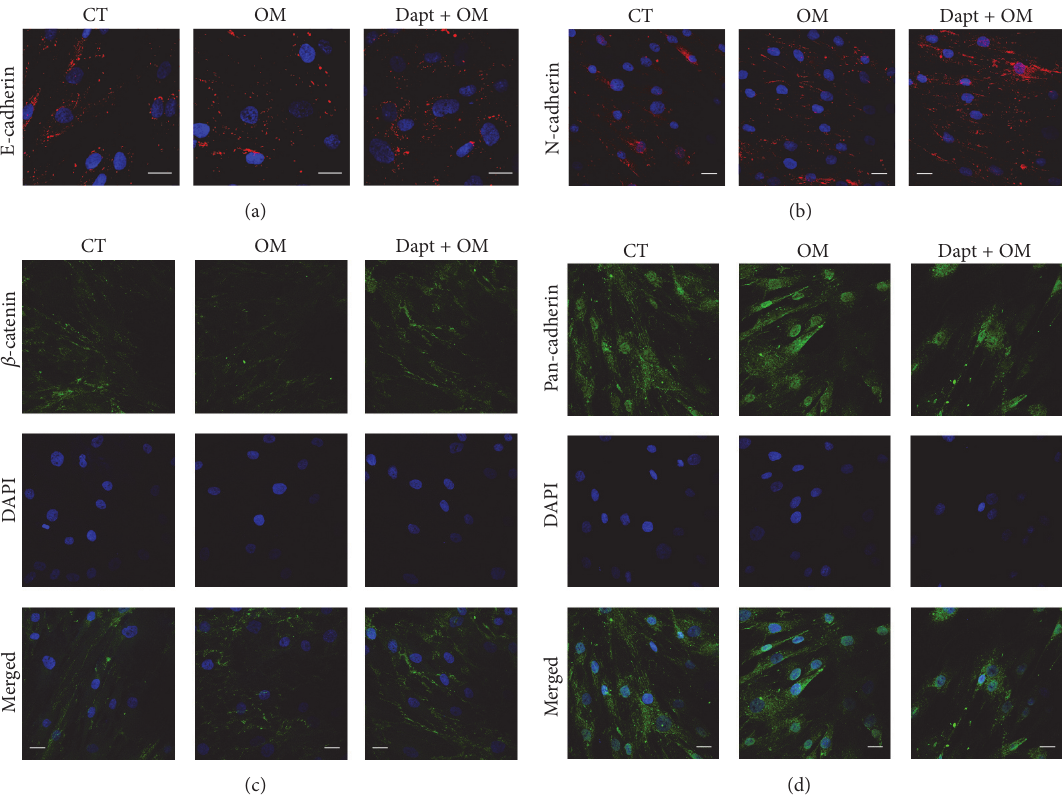
Figure 3: Expression of E-cadherin, N-cadherin, and 𝛽 -catenin in osteoinduced and Dapt-treated BMSCs. Confocal microscopy images showing the expression of E-cadherin ((a) red), N-cadherin ((b) red), 𝛽 -catenin ((c) green), and Pan-cadherin ((d) green) by BMSCs cultured for 48 h with expansion medium (CT, control undifferentiated), osteogenic medium (OM), or osteogenic medium containing 20 𝜇 M of the PS1/ 𝛾 -secretase inhibitor Dapt (Dapt + OM). Dapt was added 24 h before the addition of OM. Nuclei were stained with DAPI (blue). Scale bars = 25 𝜇